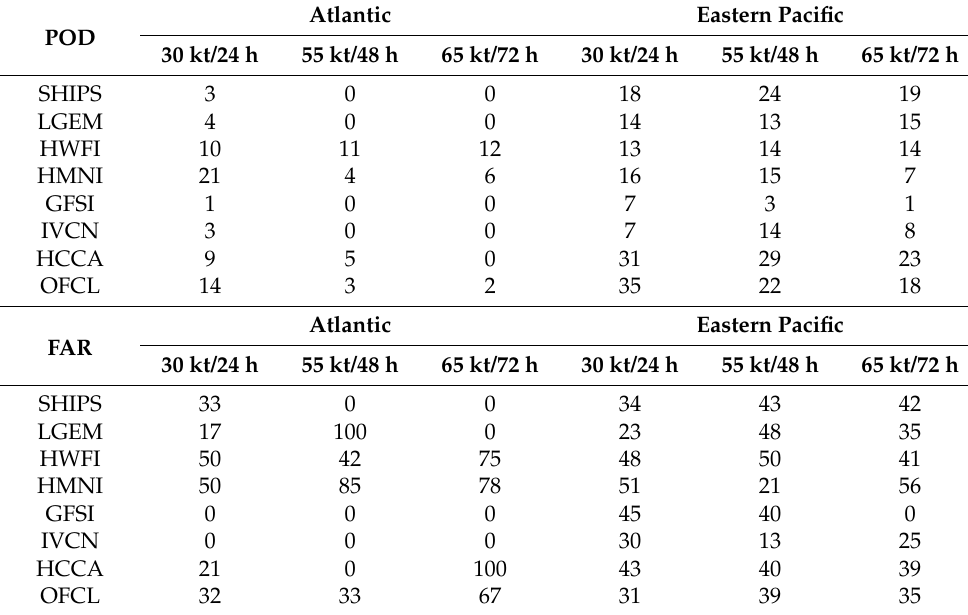
Table 6. POD and FAR (%) for the 2016–2020 Atlantic and eastern Pacific samples for NHC’s deterministic intensity models for three RI